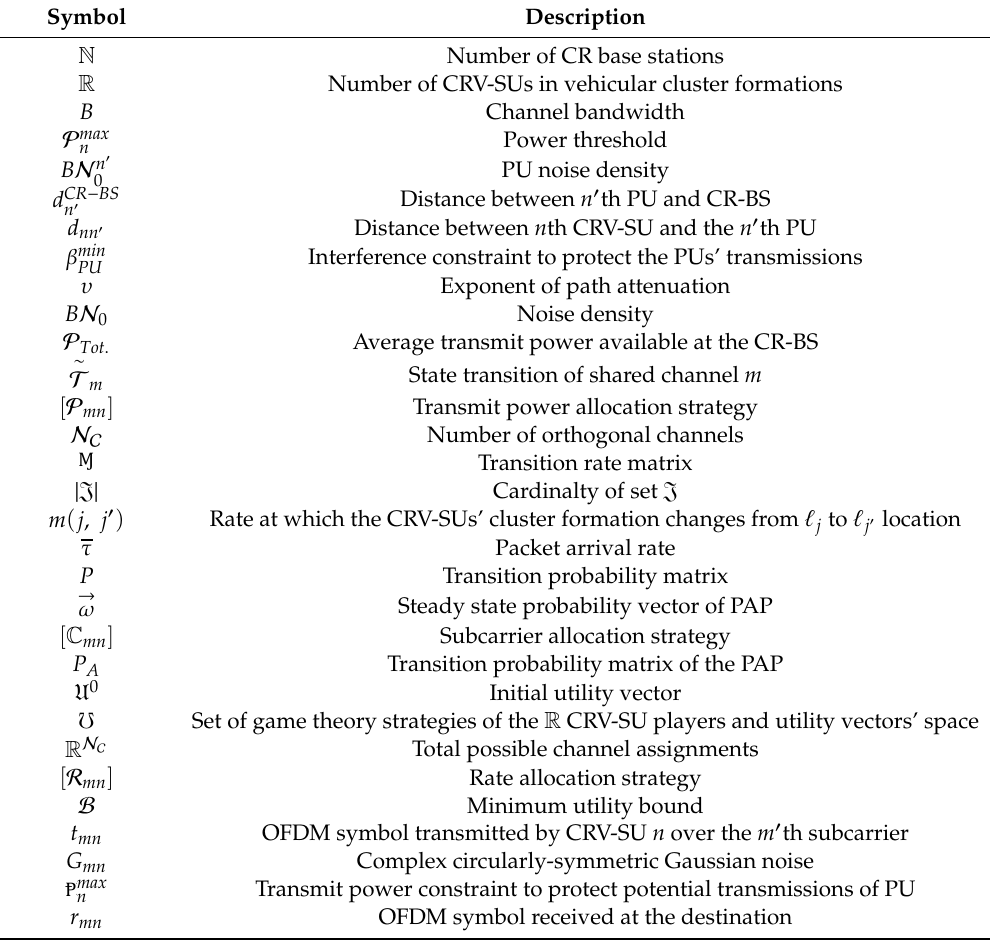
Table 2. List of